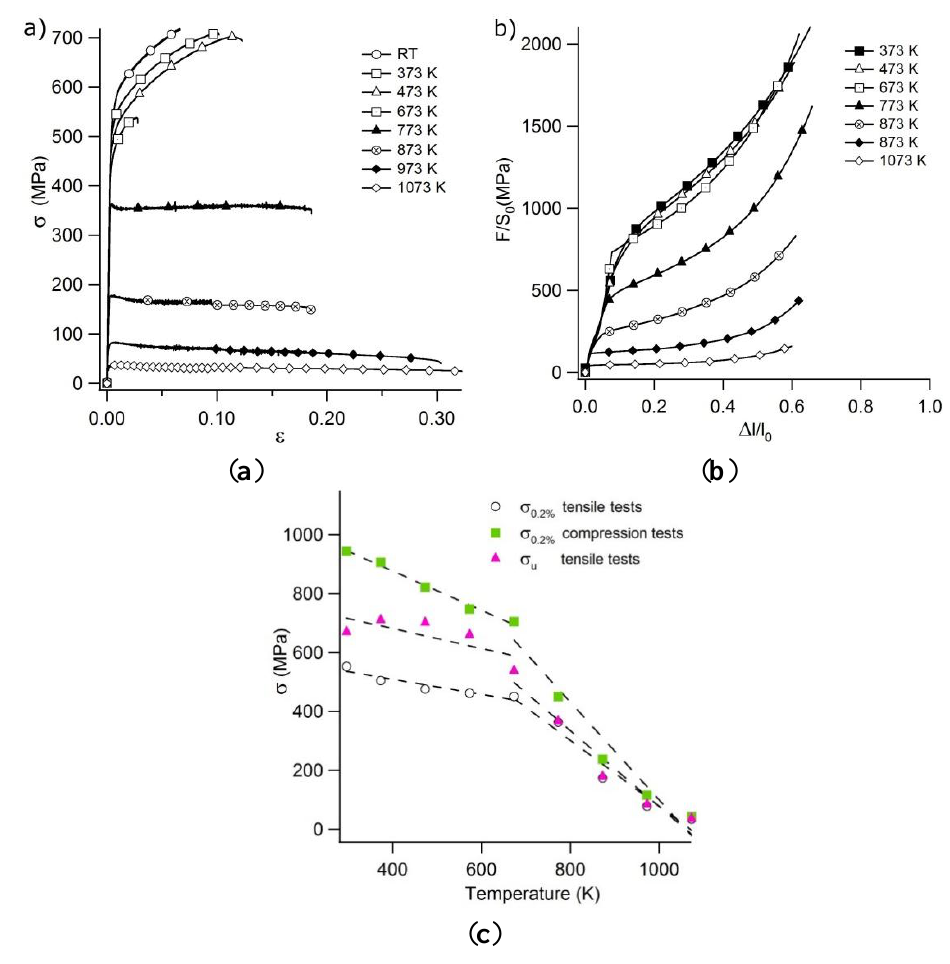
Figure 2. ( a ) True monotonous tensile curves and ( b ) engineering compression curves as a function of the temperature. ( c ) Evolution of the conventional yield stress σ 0.2 and the ultimate stress σ u with the